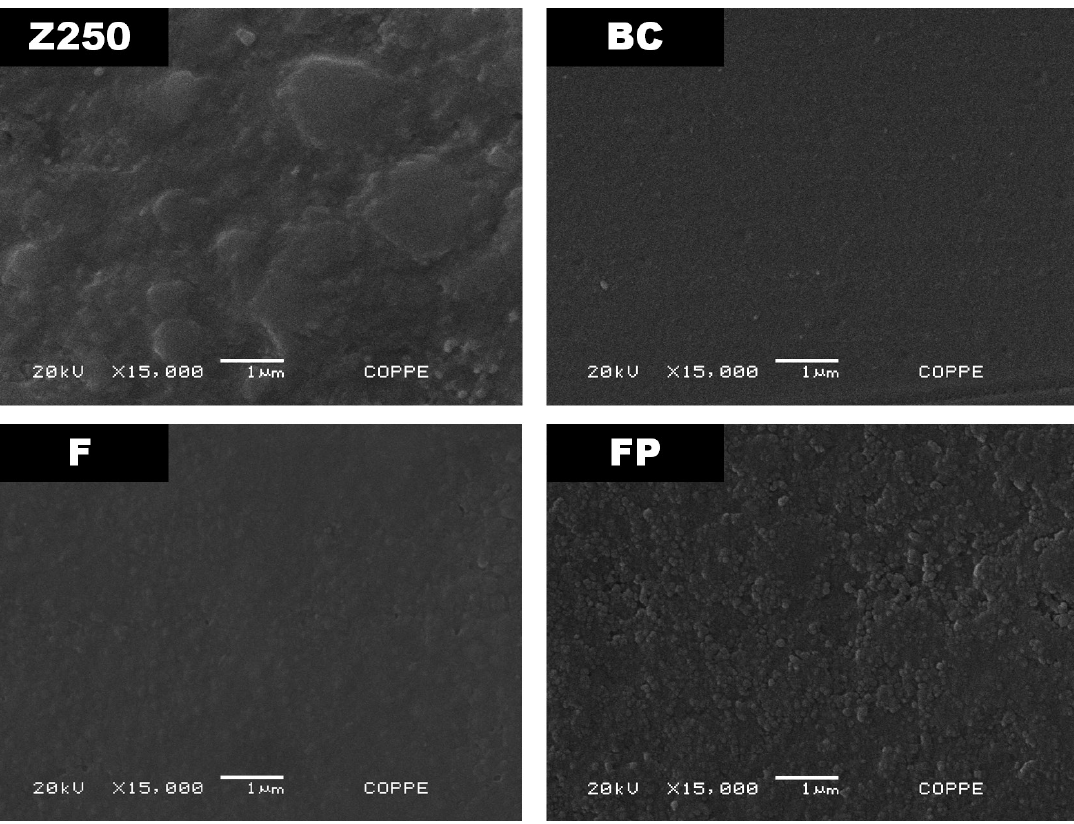
Figure 1. Surface morphologies observed by scanning electron microscopy of the following samples: bare Filtek Z250 ® composite resin (Z250), and Z250 samples filled with BisCover ® (BC), Fortify ® (F) and Fortify Plus ® (FP) sealants. The sample filled with FillGlaze ® sealant (not shown) presented very similar surface morphology to F and BC